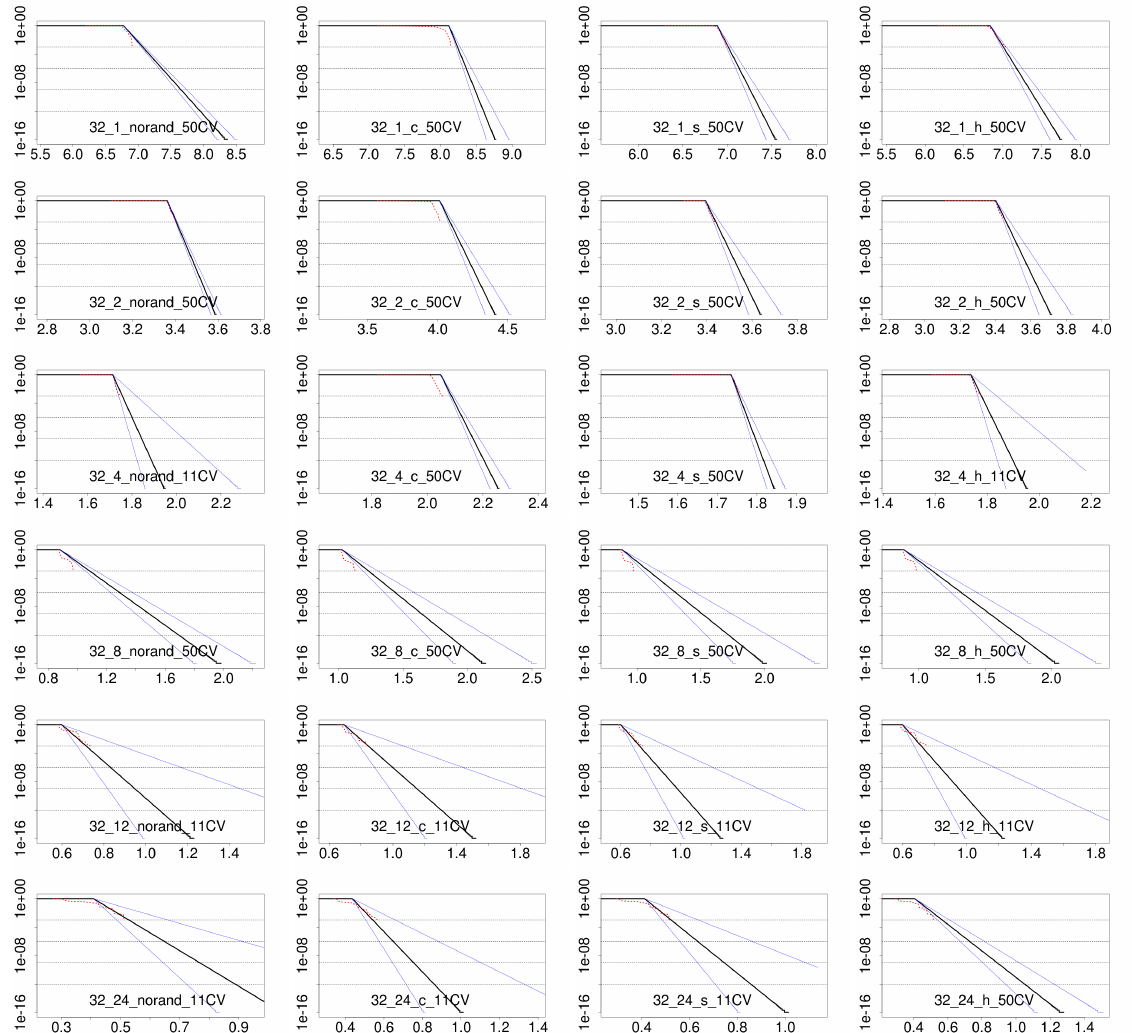
Figure 6. pWCET distributions for the Full Waveform Inversion (FWI) application for a problem size of 32 × 32 × 32. Plots correspond from top to bottom to no randomization, code randomization, stack randomization, and heap randomization respectively; and from left to right to 1, 2, 4, 8, 12 and 24 threads